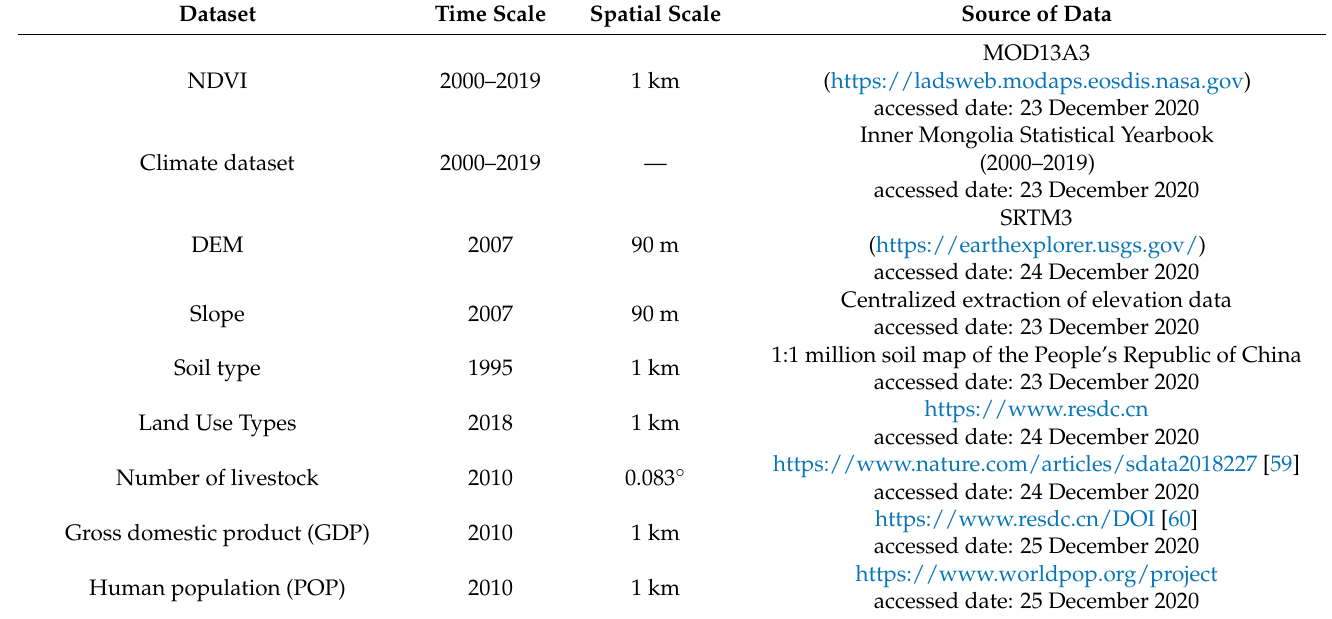
Table 1. Sources of